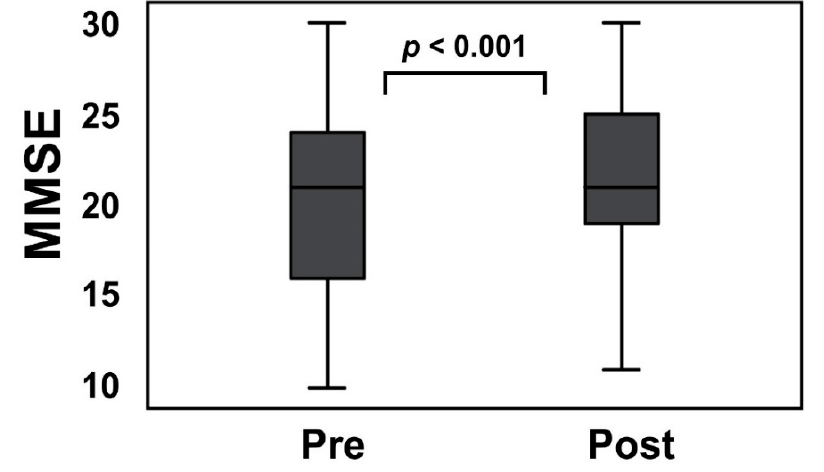
Figure 4. Folate supplementation significantly improved Mini-Mental State Examination (MMSE) in the short-term. The MMSE score improved from 20.1 ± 4.7 to 22.2 ± 4.3 ( p < 0.001, effect size 0.59) 28 days to 63 days after folate supplementation. Bar: ± SD. The MMSE score following a normal distribution was analyzed by the Student’s t -test.